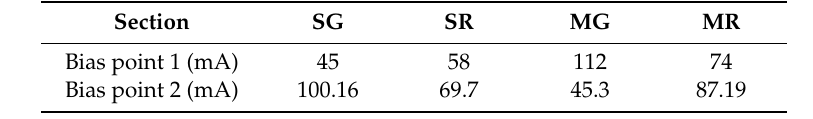
Table 4. Bias points for RIN measurements.